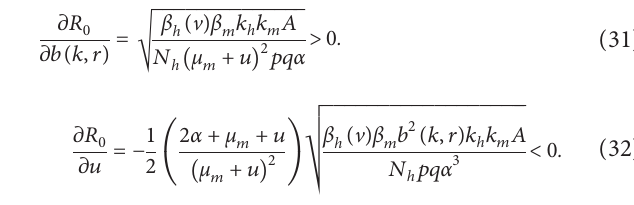
Figure 5: Sensitivity diagram of parameters β and the critical line R condition of dengue, and the blue colored area defines dengue-free